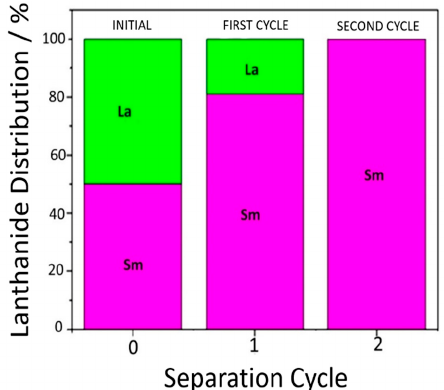
Figure 22. Fractionation of a binary mixture, starting from an equimolar solution (stage 0) of La 3+ and Sm 3+ ions, and treating with superparamagnetic nanoparticles functionalized with DTPA, as described in the text (adapted with permission from [44]).